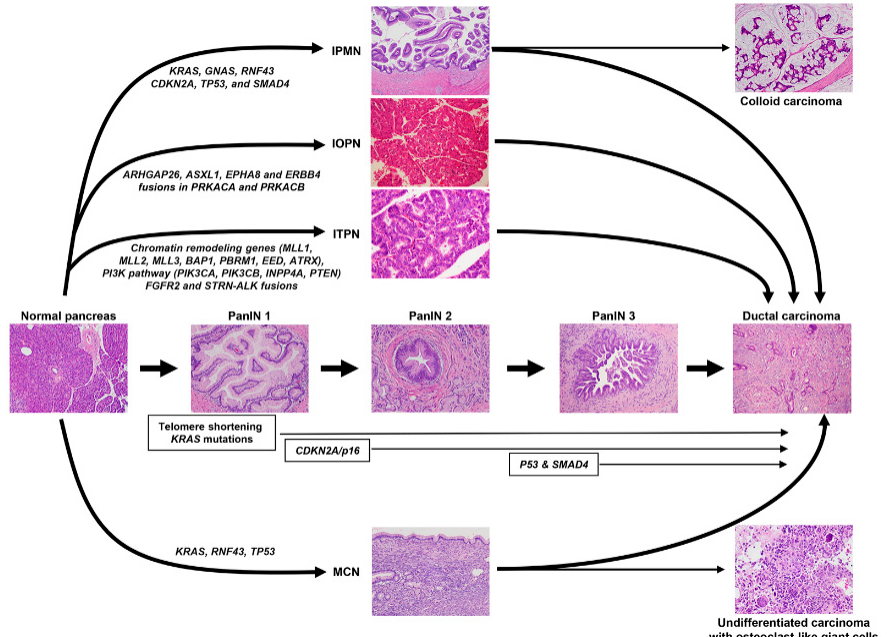
Figure 5. The precursor lesions of pancreatic ductal adenocarcinoma and the common molecular alterations. Abbreviations: PanIN, pancreatic intraepithelial neoplasia; IPMN, intraductal papillary mucinous neoplasm; IOPN, intraductal oncocytic papillary neoplasm; ITPN, intraductal tubulopapil- lary neoplasm; MCN, mucinous cystic